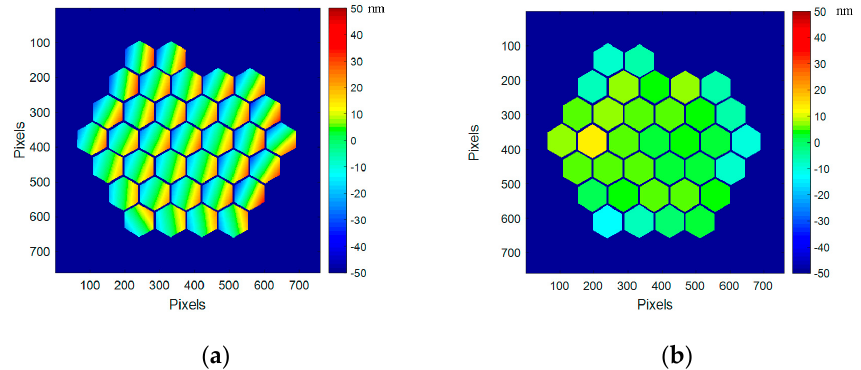
Figure 10. Residual tip-tilts ( a ) and pistons ( b ) at ambient, when the best flat condition from Iris AO is applied; the gravity effect has not been removed.